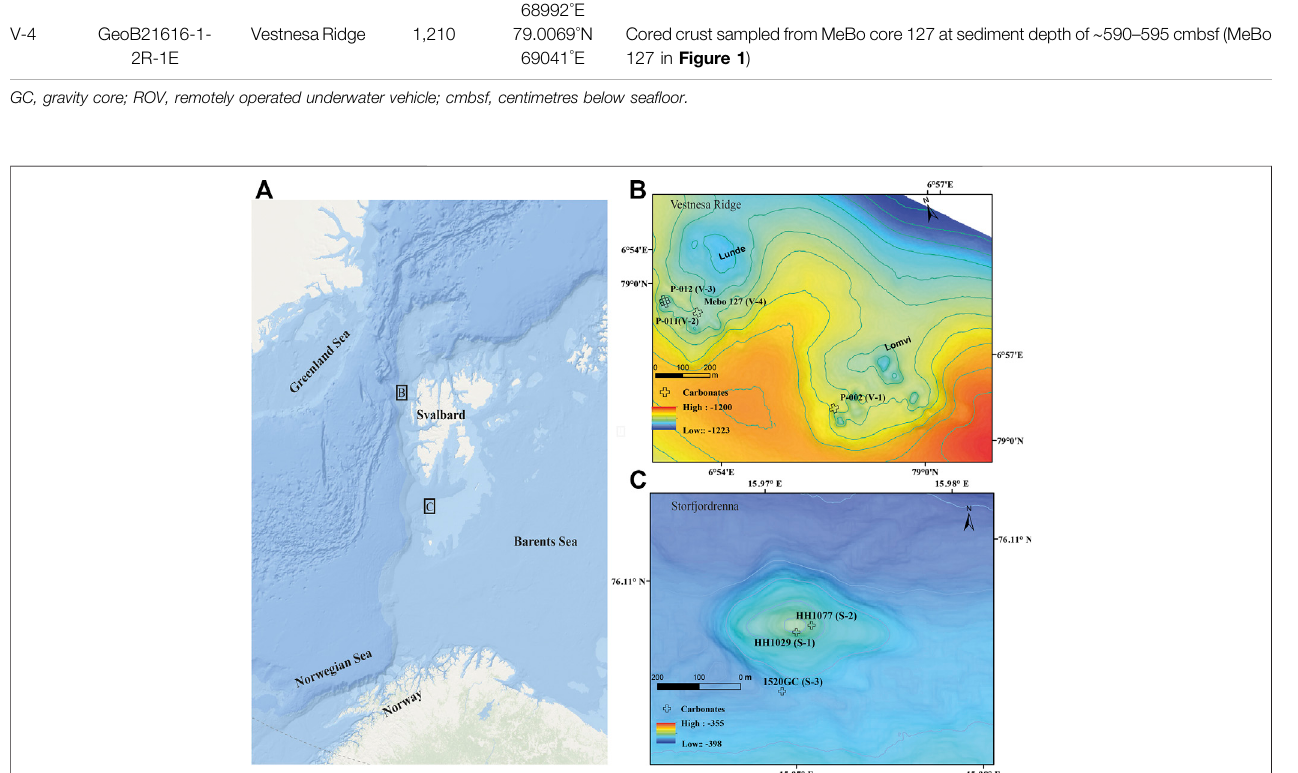
Frontiers in Earth Science |